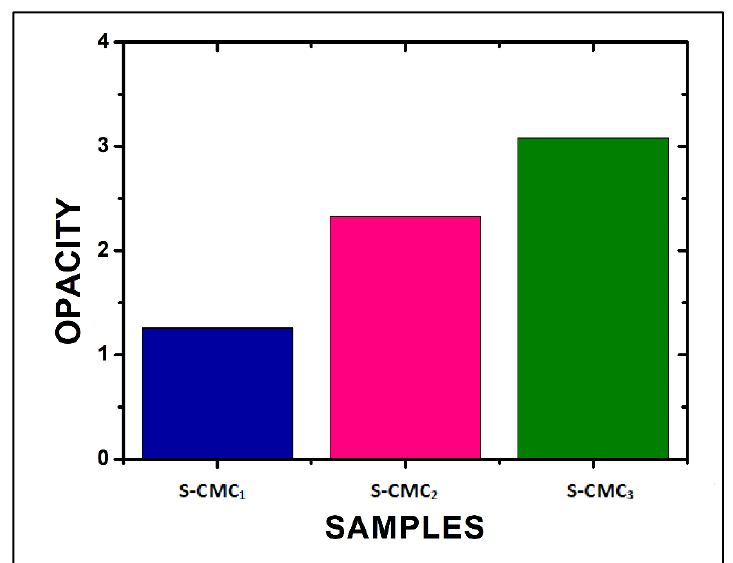
Figure 7. The opacity of the three films, evaluated at 600 nm by Equation (2).